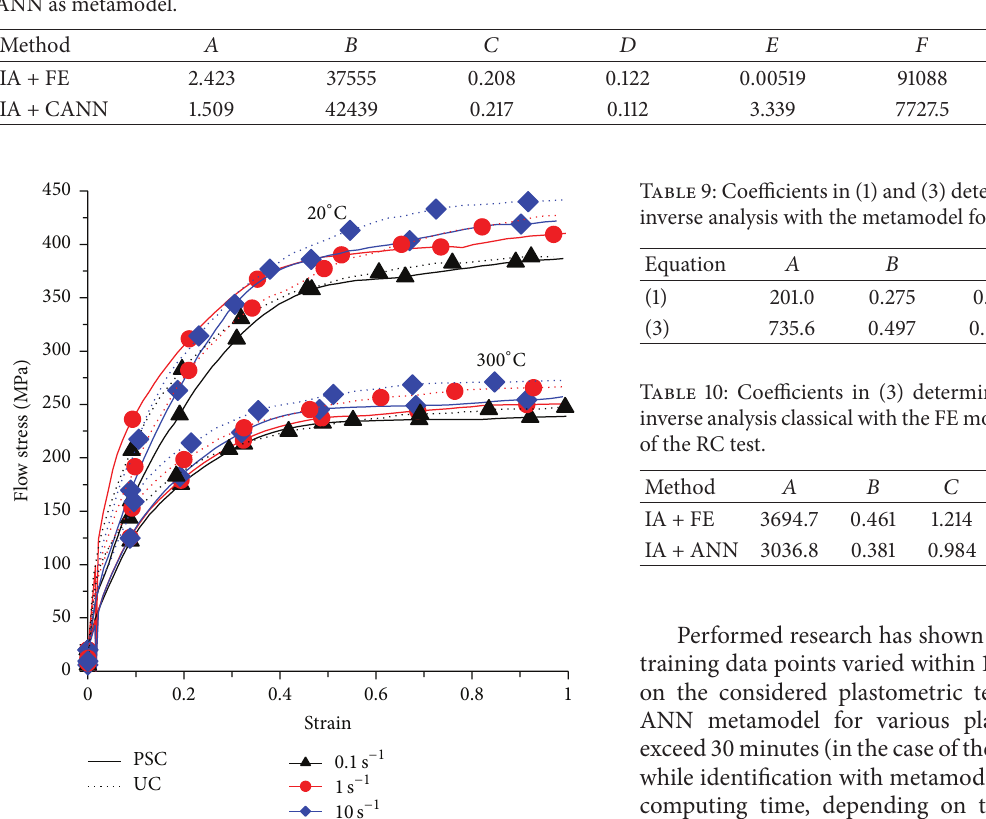
Figure 14: Flow stress calculated in a tabular form from the first stage of the inverse analysis.